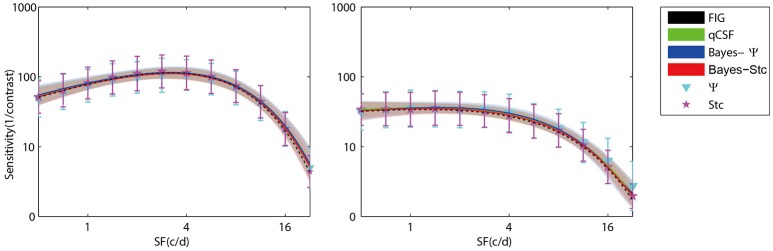
Results of simulation of a normal subject (left) and an amblyopic subject (right). CSFs obtained with FIG, qCSF, Bayes-Ψ, Bayes-Stc, Ψ, and Stc methods for 108 trials. The shaded region and error bar represent 1 st.d.